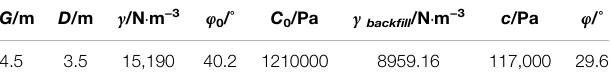
Table 11 . After numerical simulation calculation, the average width of the inelastic zone of the coal pillar in each section is shown in Table 11 , and the plastic failure of each section is shown in Figure 9 .